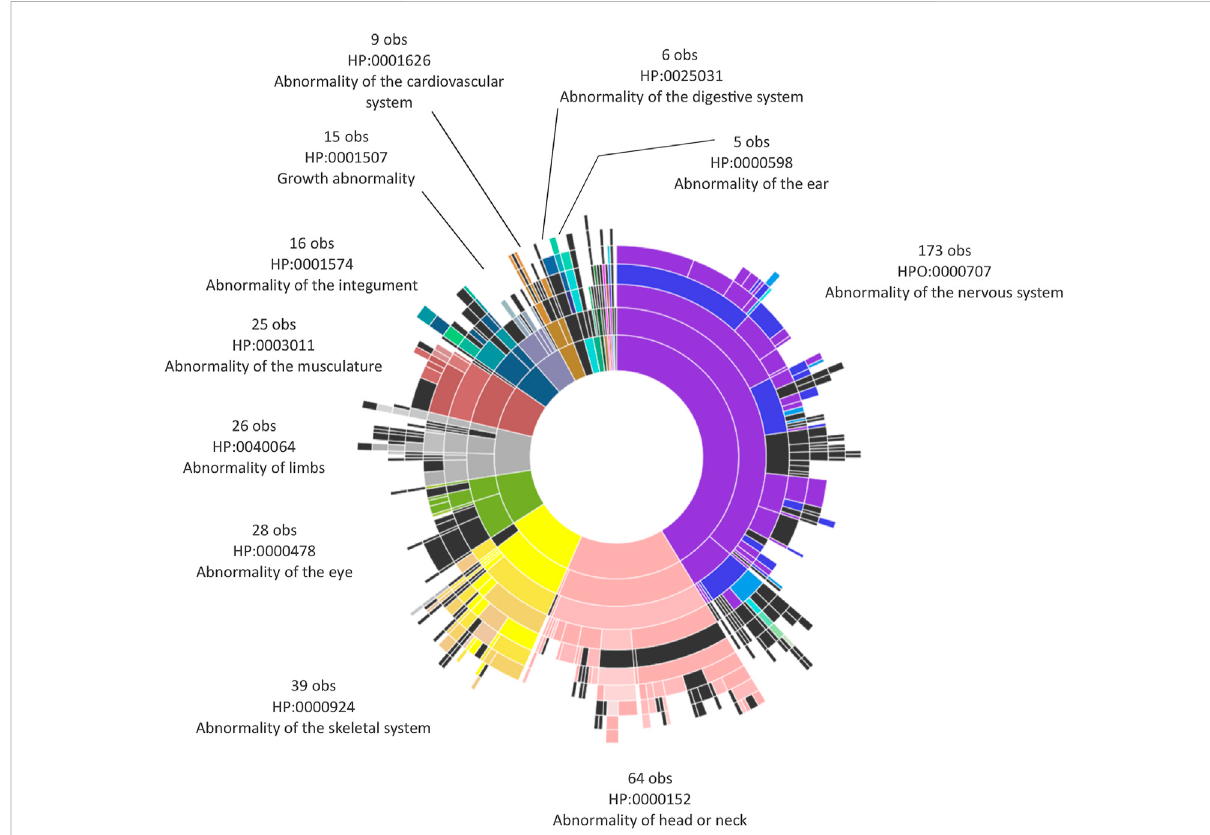
FIGURE 1 HumanPhenotypeOntology(HPO)termsobservedinthecohort.Sunburstplotdepictingthehierarchicalorganizationofontologiesdescribed in our cohort, based on the Human Phenotype Ontology (http://purl.obolibrary.org/obo/hp.obo; format-version: 1.2; data-version: hp/releases/ 2019-02-12). The phenotypic abnormalities, representing the roots or the topmost terms in the hierarchy, are depicted as semi-circular sections at the center of the sunburst. For each phenotypic abnormality and its corresponding HP code, the number of observations stemming from each root is reported. The Sunburst plot was obtained using the JavaSript library D3.js — https://d3js.org